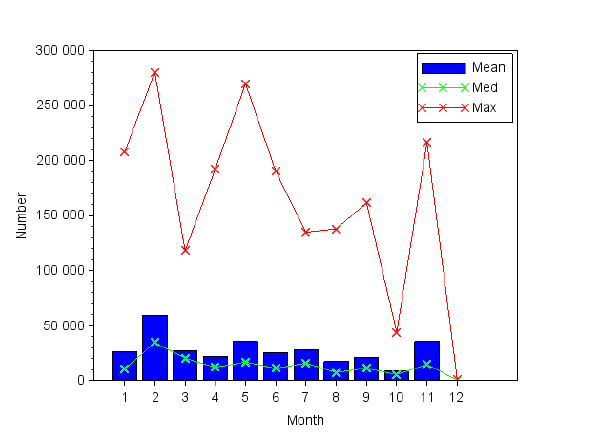
Figure 5. The size of detected area on images from individual months Figure 6. The frequency of occurrence position of detected areas of a combination of criteria BT + Tropo + Jet (see